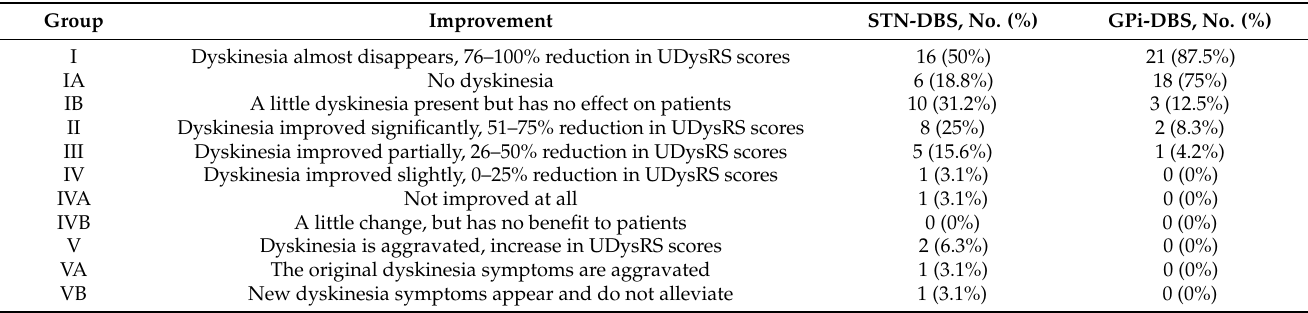
Table 2. A grouping approach for Dyskinesia based on the